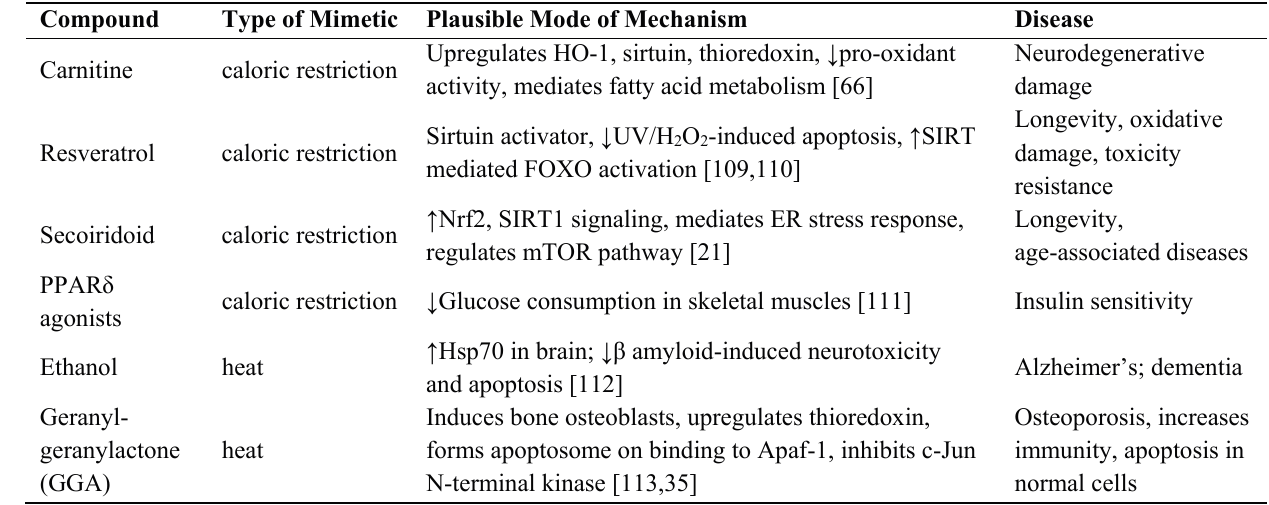
Table 2. Hibernation mimetics associated with disease